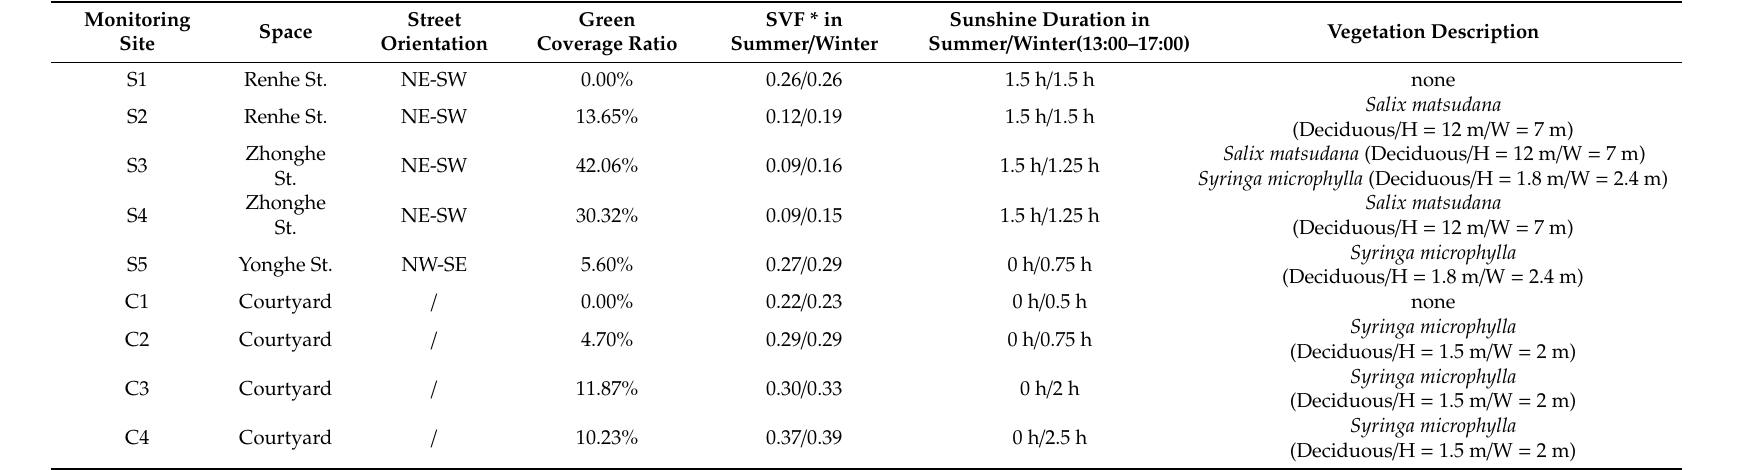
Table 1. Spatial geometric parameters and greening condition of each monitoring